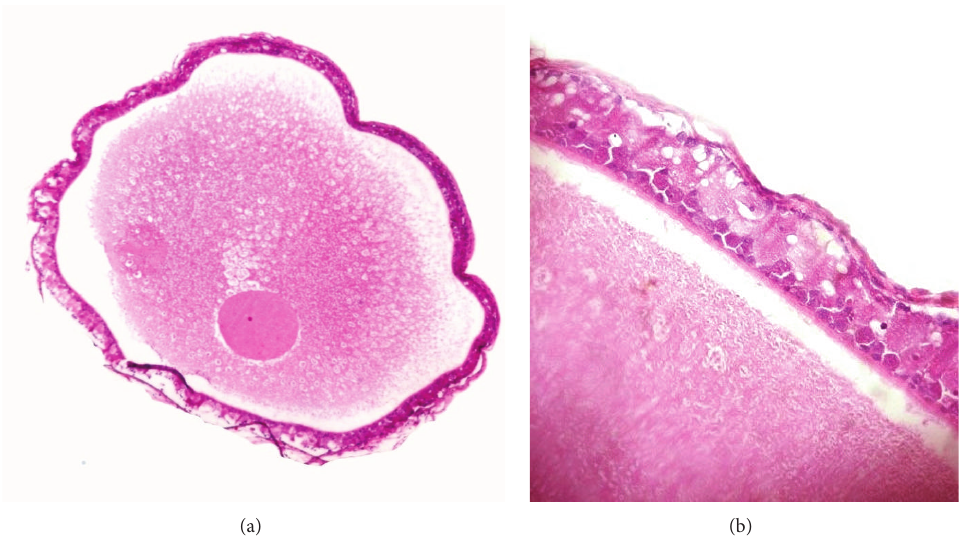
Figure 3: The growing follicle (a) and follicular layer (b) of Teratoscincus bedriagai on 5 June.